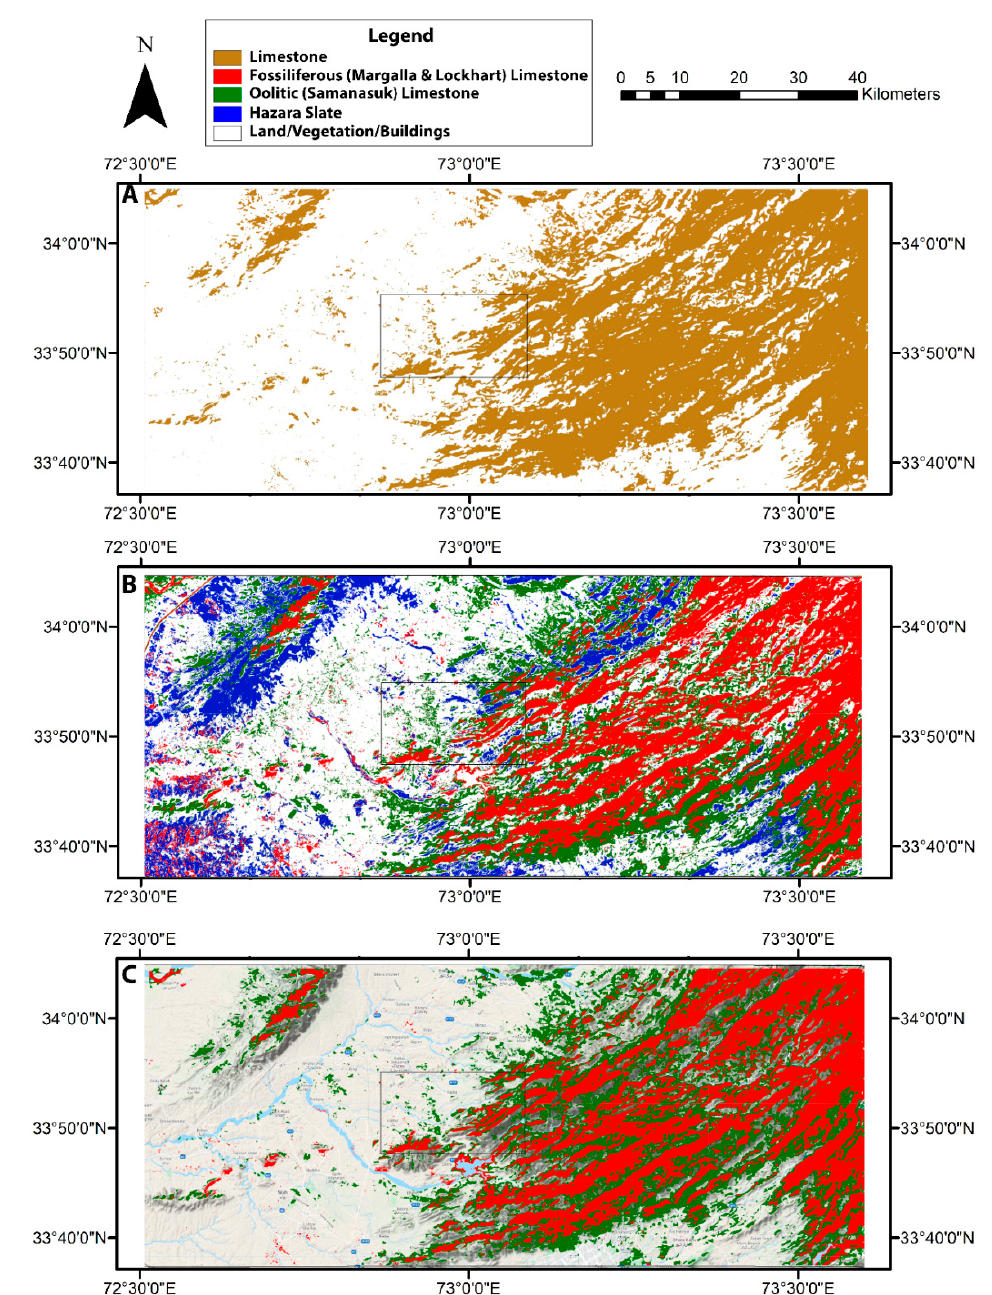
Figure 7. Final classification of “area under study” shown as three subfigures obtained from Landsat-8: ( A ) Limestone classification results by CART application on Landsat-8 composite, ( B ) limestone (oolitic and fossiliferous), and Hazara formation classification using random forest application on Landsat-8 composite, ( C ) limestone (oolitic and fossiliferous) formation map obtained using random forest application on Landsat-8 composite after using limestone binary classification map shown in “A” as a mask (this map is overlaid on terrain map with grey zones indicating slopes within the region). Field visits (shown in Figure 8) performed along the traverse shown in Figure 1 val- idated the binary limestone map reported by application of CART algorithm on Landsat- 8. Several limestone-bearing formations with predominantly limestone lithology (i.e., Sa- mana Suk formation, Lockhart and Margalla Hill limestones) and those with limestone and interbedded shale (i.e., Kawagarh, Patala, and Chorgali formations) were differenti- ated.